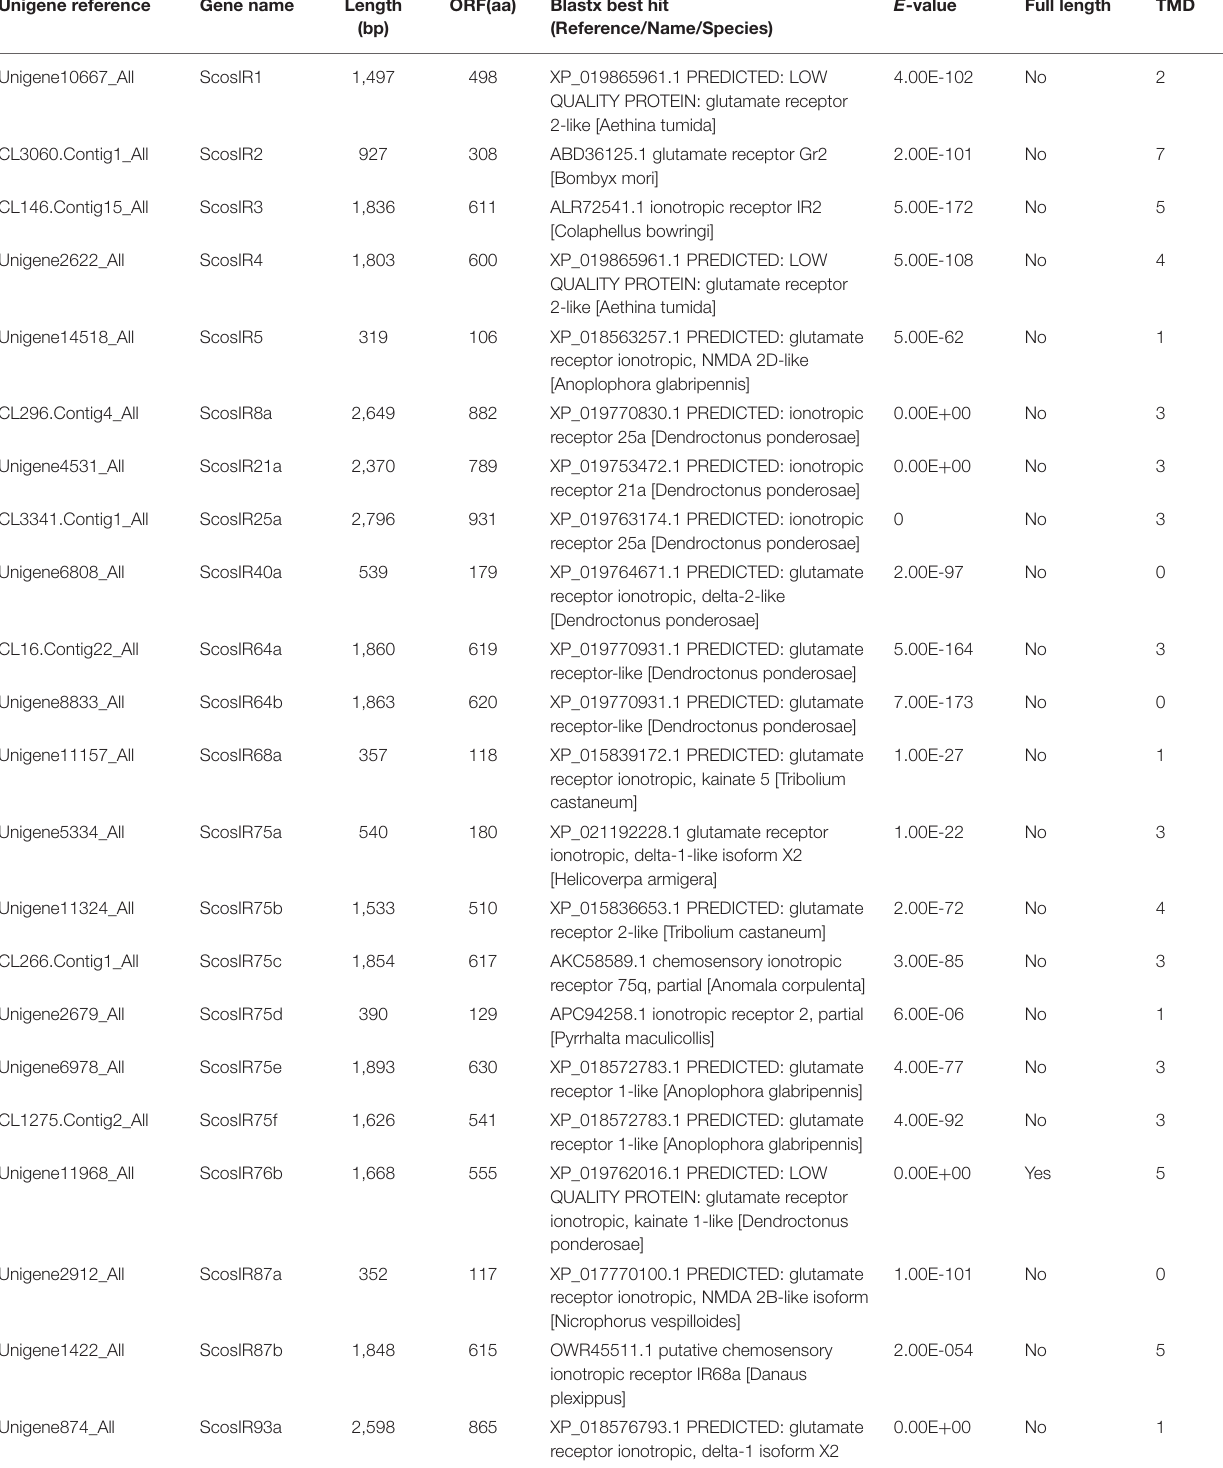
TABLE 2 | Unigene of candidate ionotropic receptors. Unigene